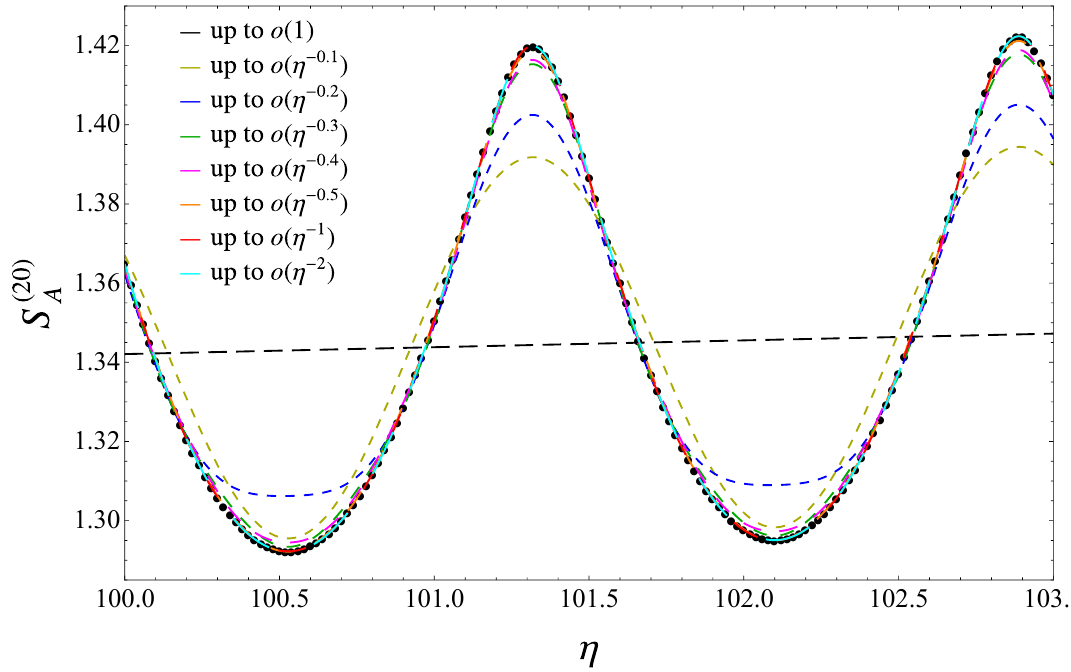
Figure 10. The Rényi entropy of order α = 20 in the regime of large η